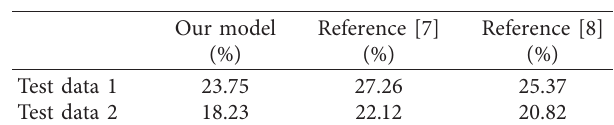
Table 4: The mean localization error rate of Z -axis of different